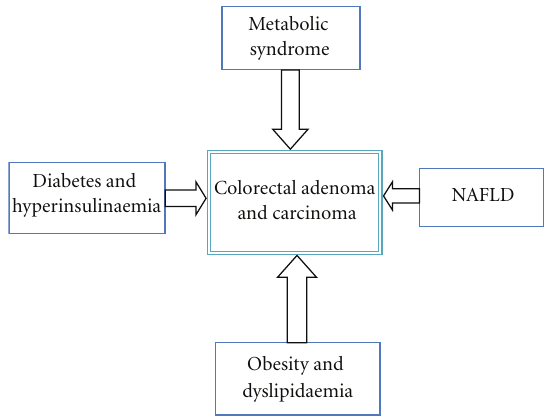
Figure 1: Relationship between metabolic syndrome, NAFLD, and development of colorectal adenoma and